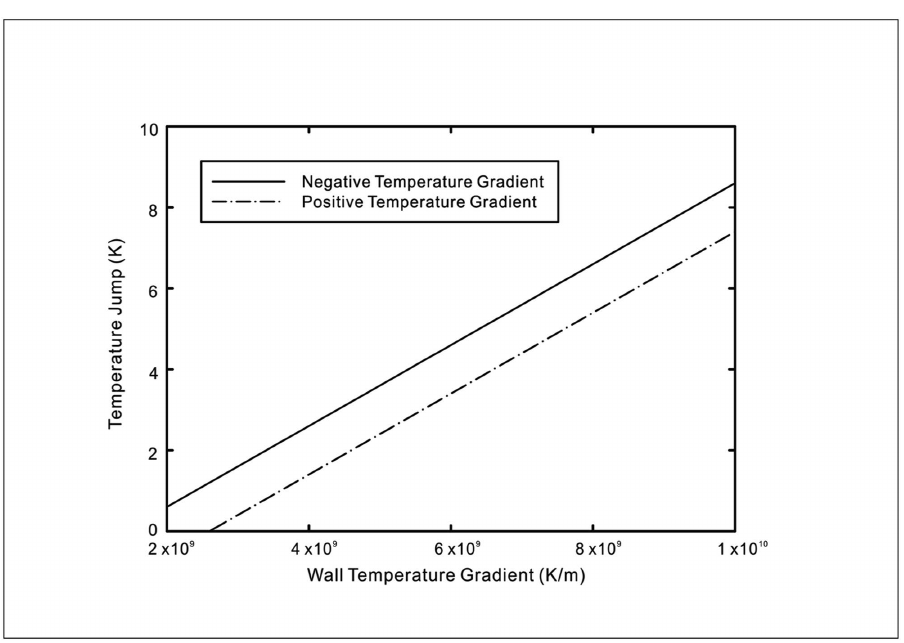
Fig 9. Thermal rectification effect with a change in direction of heat flux. A negative temperature gradientrefers to decreasing fluid temperatures with increasingnormal distance from the solid surface and vice versa for a positive temperature